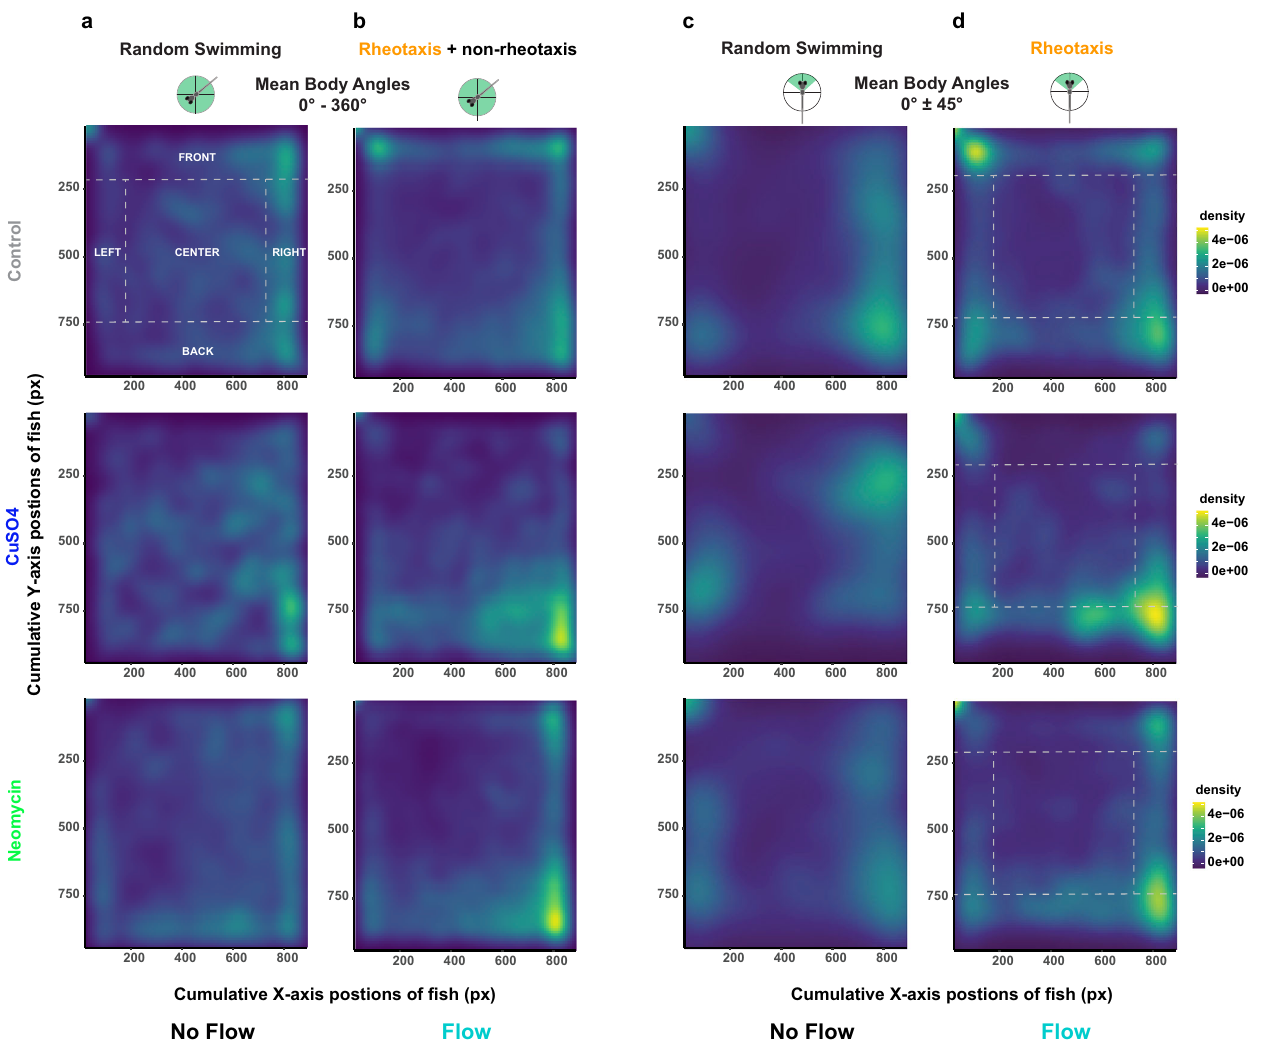
Fig. 5 Under fl ow, lateral line intact (control) fi sh used the front part of the arena near the source of the fl ow, whereas lesioned (CuSO4, neomycin) fi sh use the back portion of the arena. a , b For all possible mean body angles (0°- 360°): a all treatment groups of fi sh show similar density, or total spatial use, of the arena under no fl ow conditions; b however, the controls (control, n = 248 fi sh) used the front of the arena and the lateral-line lesioned fi sh (CuSO4, n = 204 fi sh; neomycin, n = 222 fi sh; 18 experimental sessions) used the back of the arena under fl ow. c , d Filtering the data for mean body angles required for rheotaxis (0° ± 45°): c all groups clustered along the left and right sides of the arena under no fl ow; d but under fl ow, the controls used the front-left and the lesioned use the back-right portions of the arena. Dotted lines and labels in capital letters indicate spatial regions of interest (ROI). For clarity, statistical comparisons among treatment and ROIs were not included in the fi gure; however, there were signi fi cant fi xed effects for CuSO4 and neomycin treatments, the back ROI, and interactions between treatment and ROI (Supplementary Table